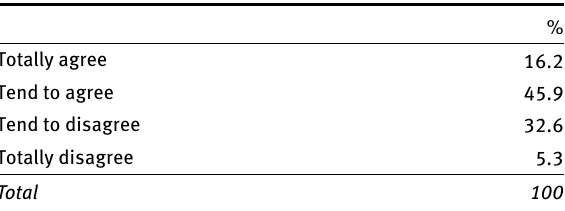
Table 3: The spread of robots will make people feel